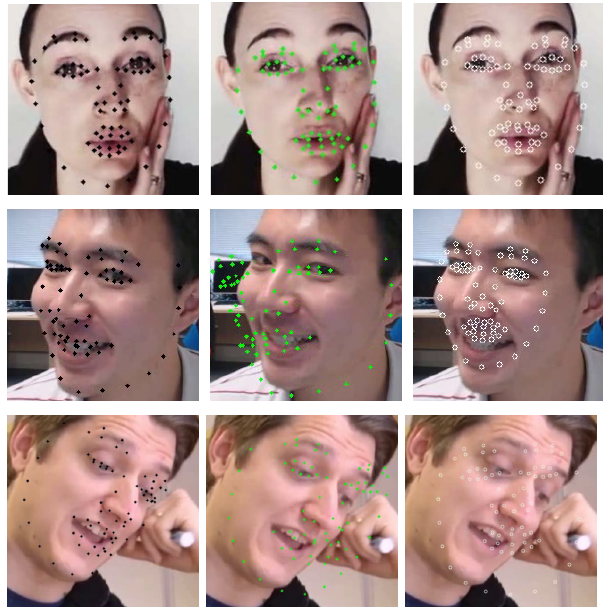
Fig. 3 Landmark tracking comparison. From left to right: ours, in-the-wild, AAM. fitted facial mesh might not exactly fit the detected